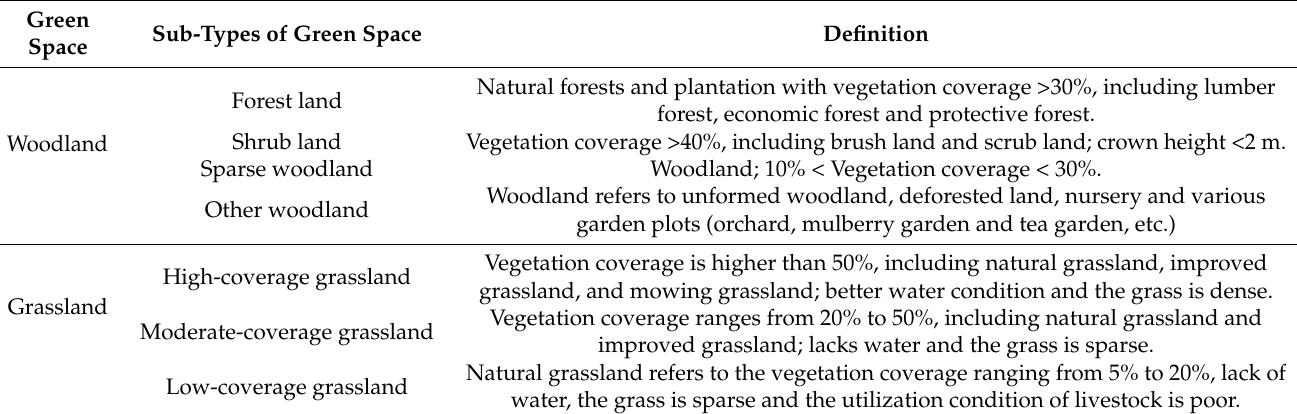
Table 2. The classification of green